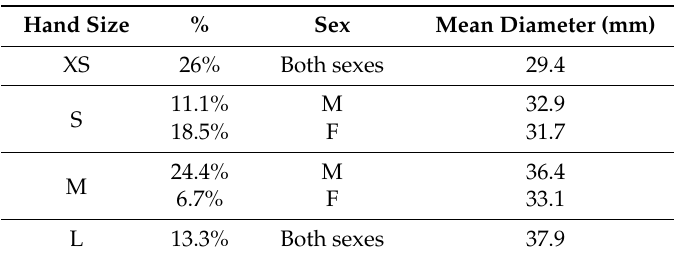
Table 2. Optimal for each of the hand size categories.